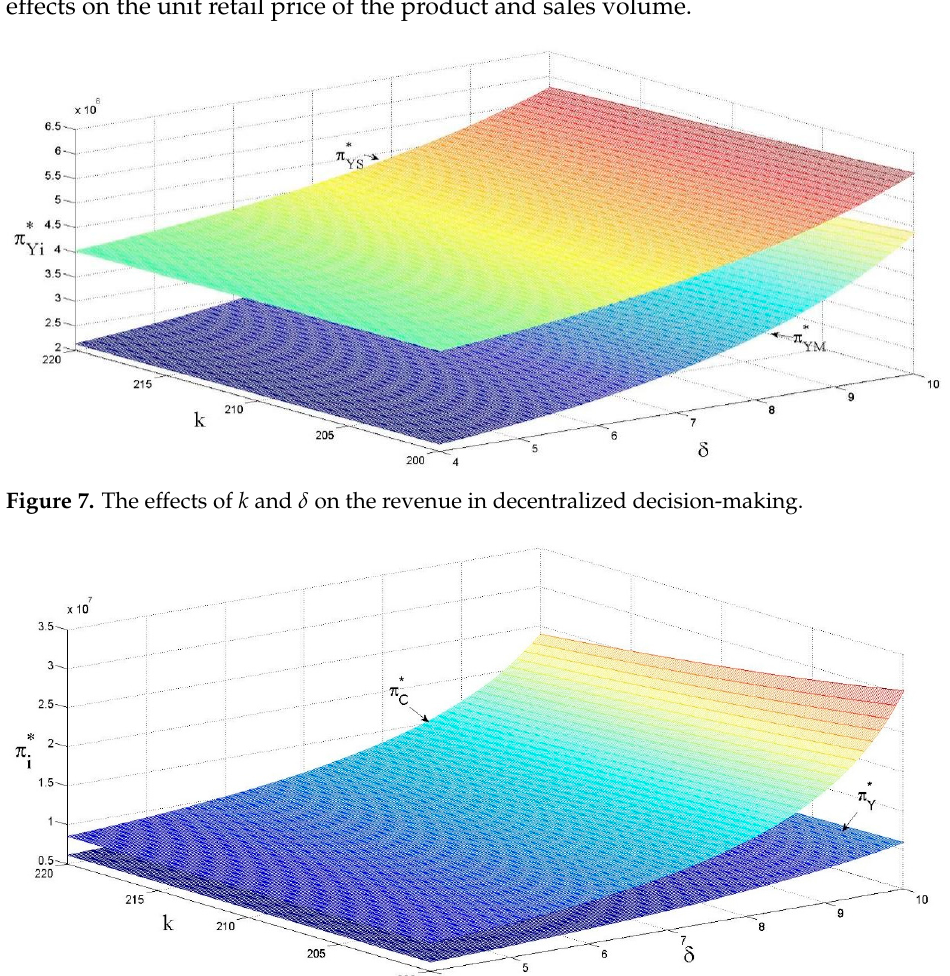
Figure 8. The effects of k and